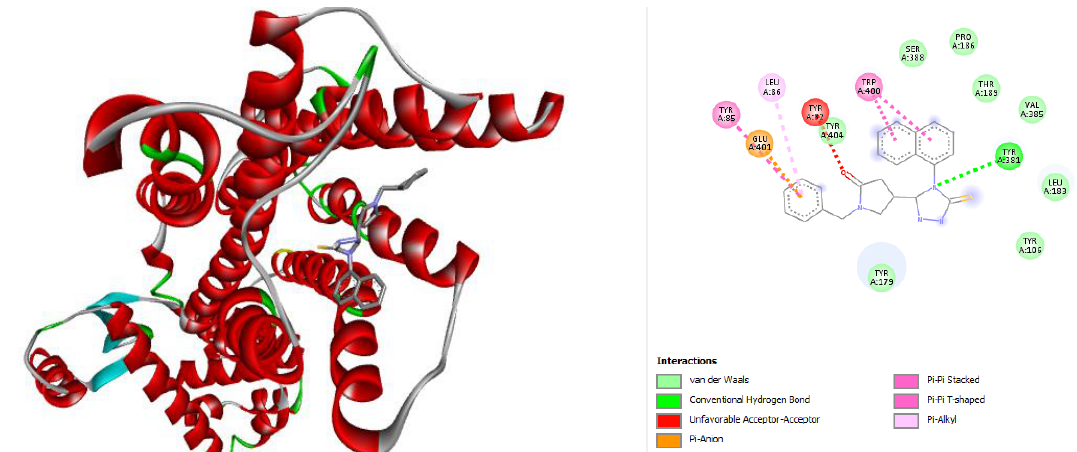
Fig. 5. Superposition of molecule 11 and diagram of intermolecular interactions in complex with muscarinic